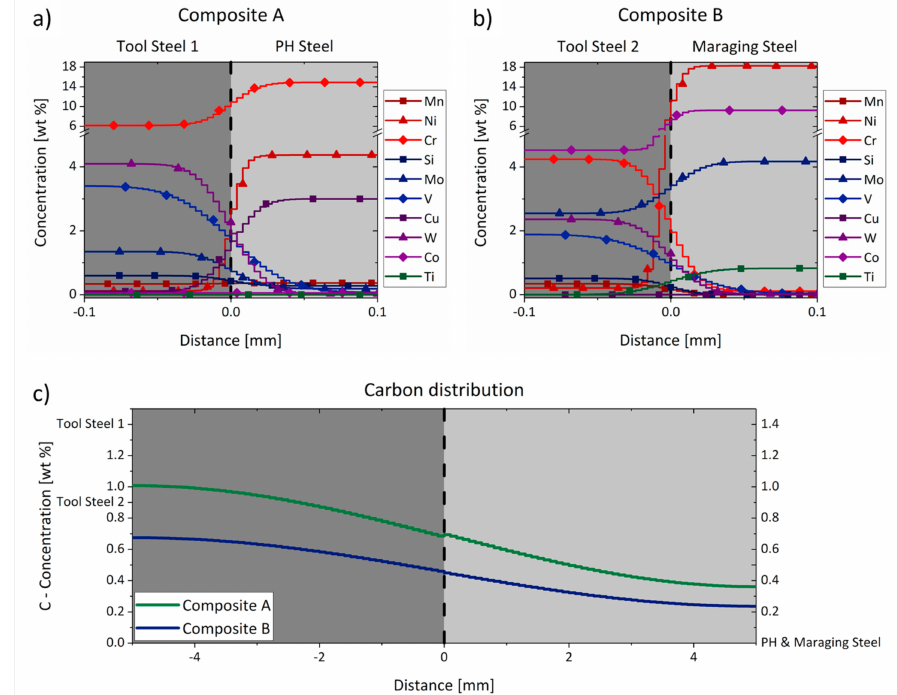
Figure 9. Simulated concentration profile of alloying elements near the interface after di ff usion bonding and heat treatment for ( a ) composite A and ( b ) composite B. The di ff usion of substitution solutes is in the range of 10–50 µ m. The carbon distribution of the whole sample for both composites is displayed in ( c ). The carbon concentration of the base alloys is marked on the left side for the cold work tool steels and on the right for the PH and maraging